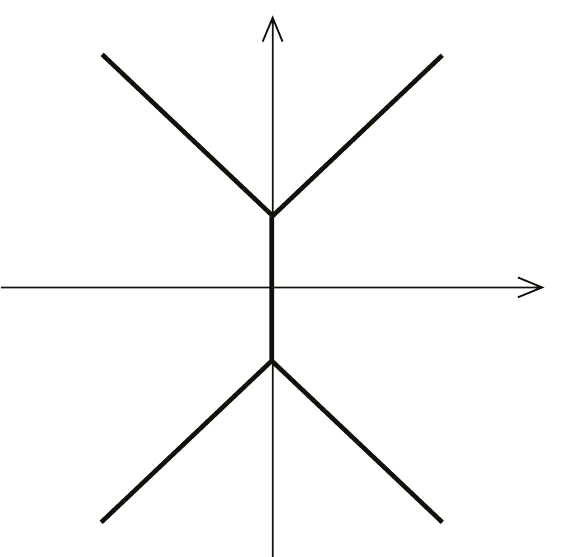
Figure 4 . The Stokes lines for the inverted quadratic potential ( E > V ). The branch points are the complex “turning points.”.